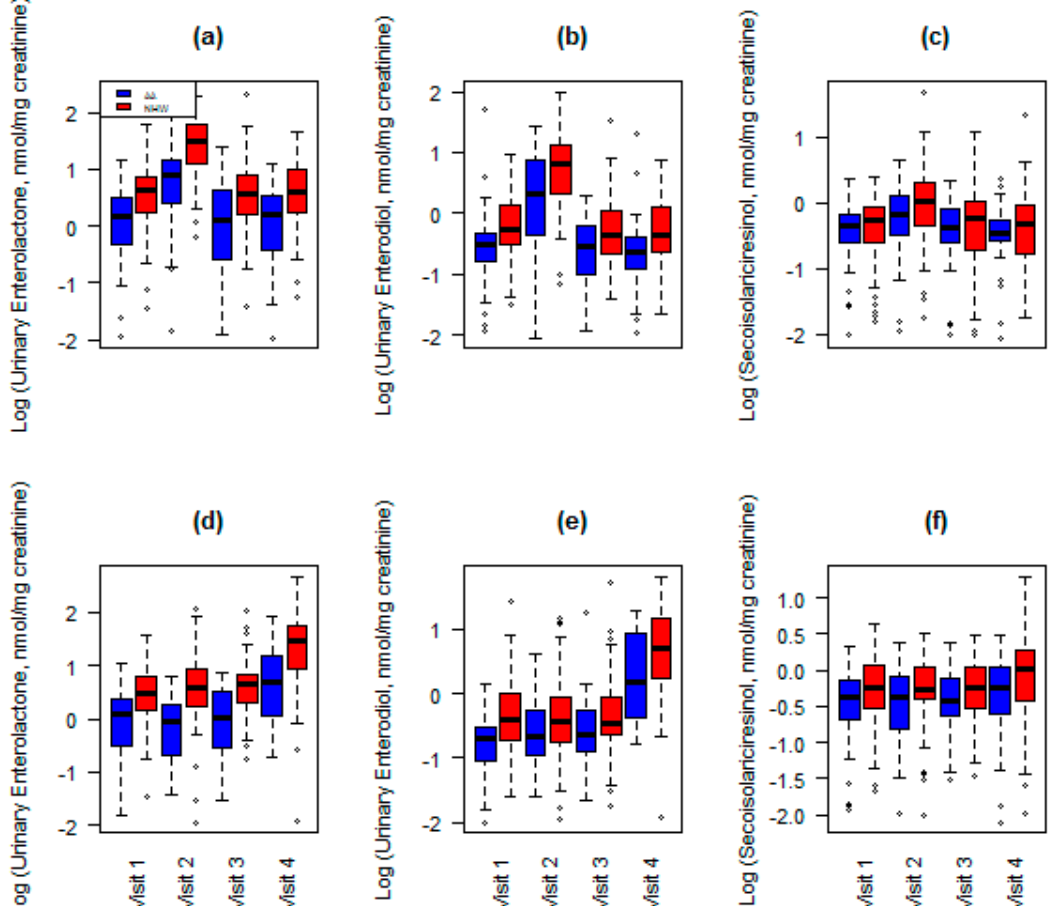
Figure 1. Urinary lignan excretion by randomization group, visit, and ethnicity compared with repeated measures ANOVA adjusting for age, body mass index, and flaxseed (FS) consumed. Blue bars represent women of African ancestry; red bars represent women of European ancestry. Figure 1a–c represent enterolactone (ENL) ( a ), enterodiol (ED) ( b ), and secoisolariciresinol (SECO) ( c ) excretion, by visit, for women assigned to treatment group 1 (FS first 6 weeks). As expected, excretion of these lignans increases between visits 1 and 2 and is relatively unchanged between visits 3 and 4. Figure 1d–F represent ENL ( d ), ED ( e ), and SECO ( f ) excretion, by visit, for women assigned to treatment group 2 (FS last 6 weeks). Similar to effects observed in group 1, excretion of these lignans increased between visits 3 and 4 in response to FS supplementation. ENL, ED and SECO excretion increased statistically significantly after FS in both groups ( p < 0.0001).